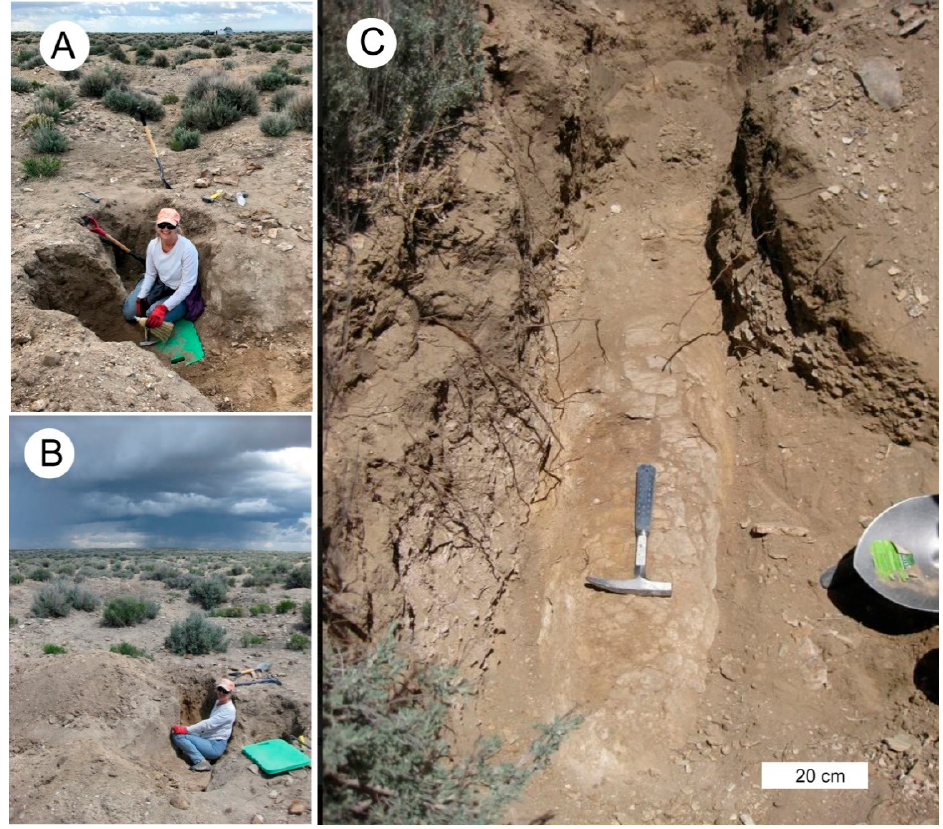
Figure 5. Blue Forest site. ( A , B ) Trenches excavated during 2018 field work. ( C ) Partially exposed horizontal log, showing thick stromatolitic coating. Photos by MikeViney.